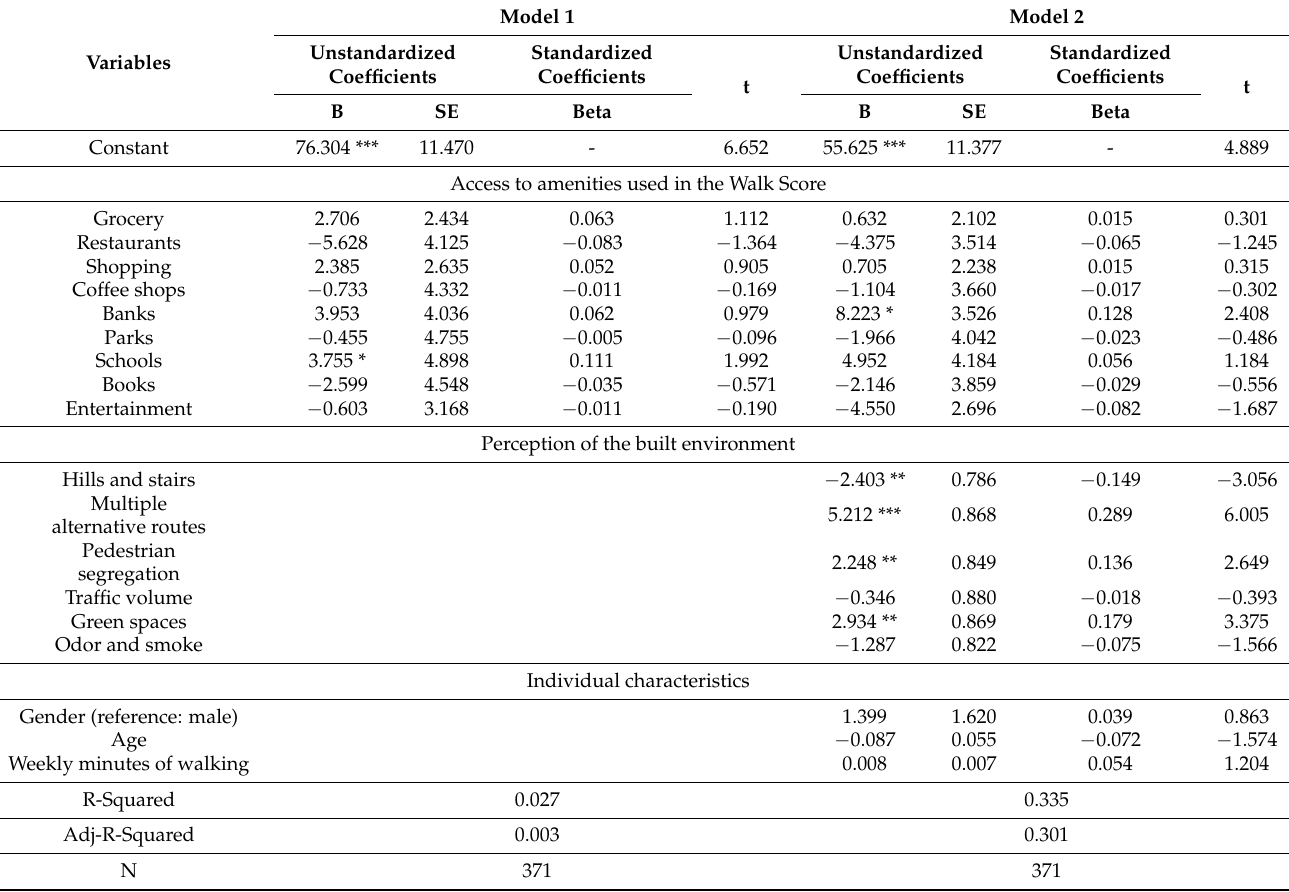
Table 3. Built environmental correlates with perceived neighborhood walkability: multiple regres- sion